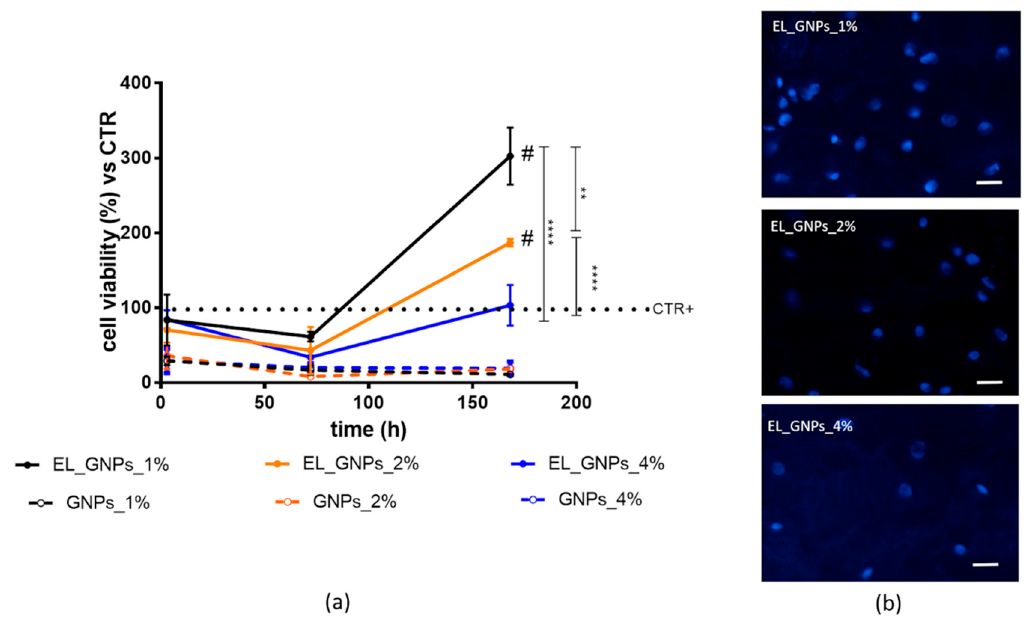
Figure 4. ( a ) Cell proliferation profiles up to 168 h (7 d) of incubation on electrospun matrices (EL_GNP_1%, EL_GNP_2%, EL_GNP_4%) and co-incubated with equivalent amounts of free GNPs. Cells grown without support were chosen as control (CTR+). Results are expressed as cell viability percentage, mean ± SD ( n = 3). Multiple comparison test revealed significant differences for (#) p value < 0.05, (**) < 0.01, (****) < 0.0001; ( b ) fluorescence microscopy images of fibroblasts seeded on electrospun composite matrices at 168 h (7 d). Blue fluorescence denotes nuclear DNA stained with Hoechst33258 dye (obj 20 × magnification, scale bar = 20 µ